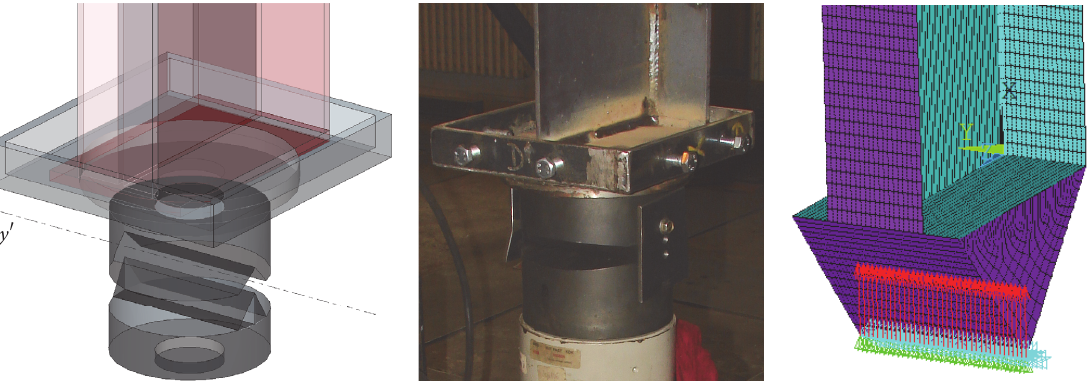
Figure 3: Knife-edge boundary conditions.